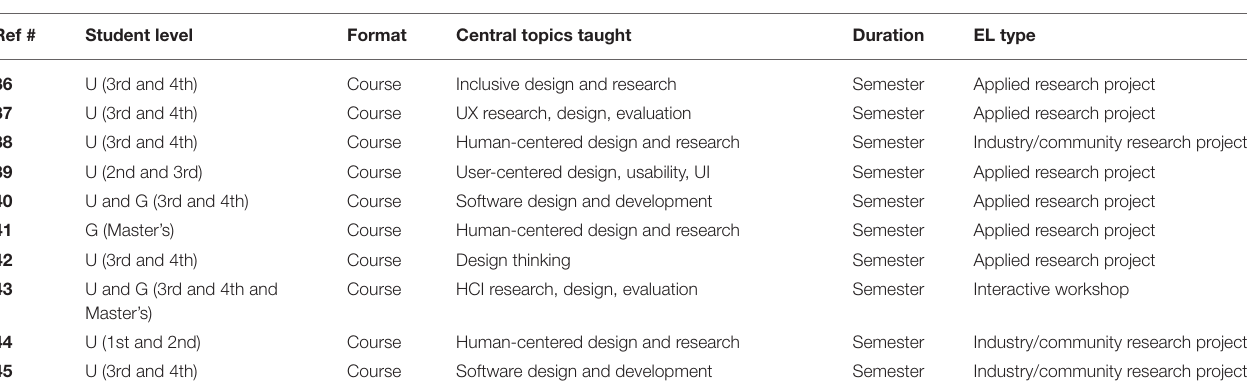
TABLE 7 | A list of EL type and respective